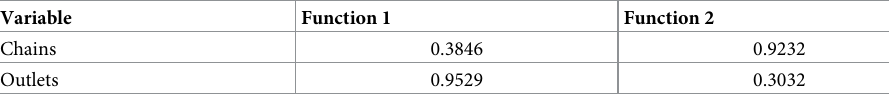
Table 7. Correlations between dependent and canonical variables.